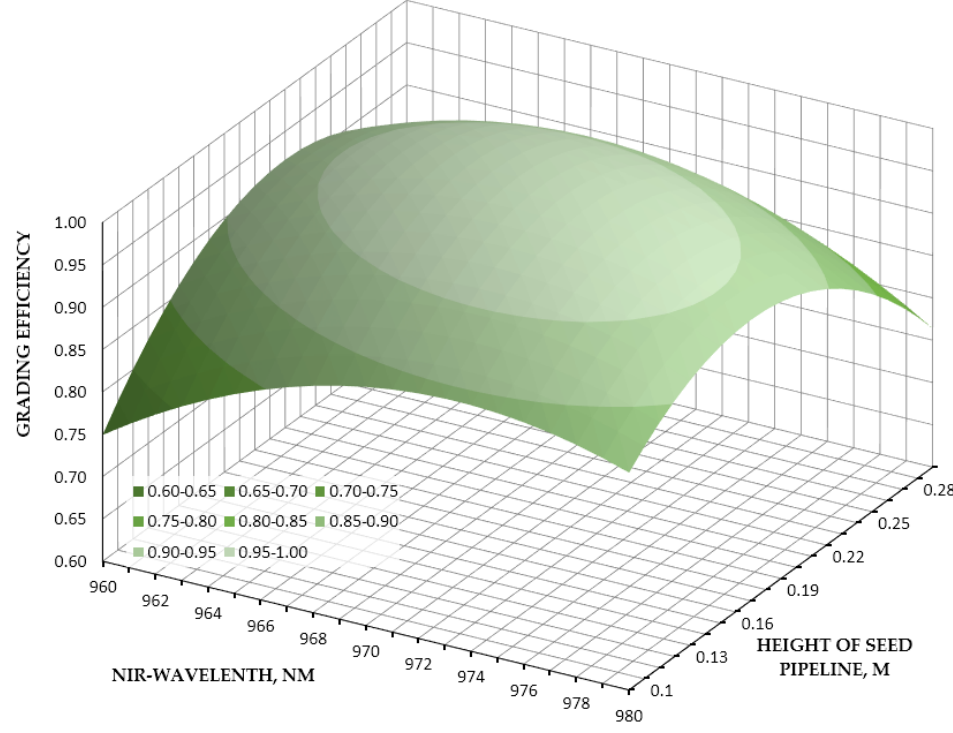
Figure 3. The response surface of the NIR grading efficiency determines the grader’s optimal engineering parameters when fixing the 45° level for the inclination angle from the light source .